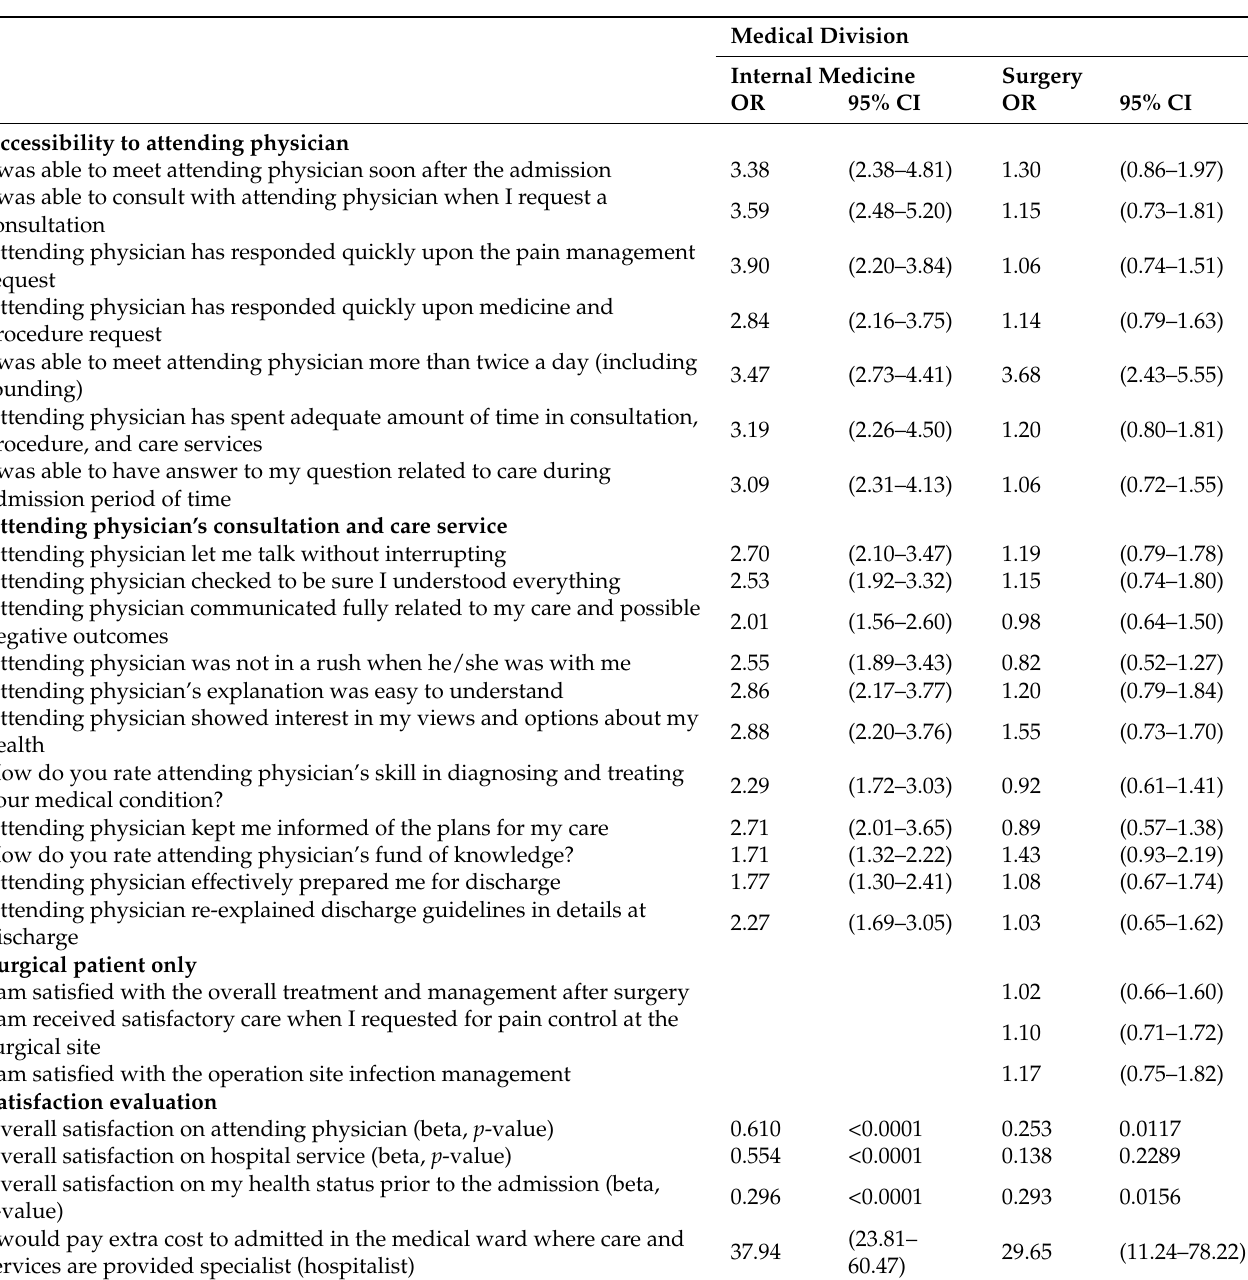
Table 3. Results of logistic regression on the patient satisfaction on attending physician in the hospitalist ward compared to the non-hospitalist ward by the medical division ‡